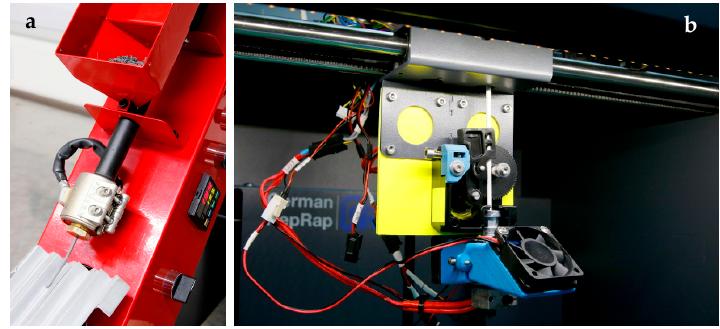
Figure 3. ( a ) Filament extruder, ( b ) modified fused filament fabrication (FFF) printer head.